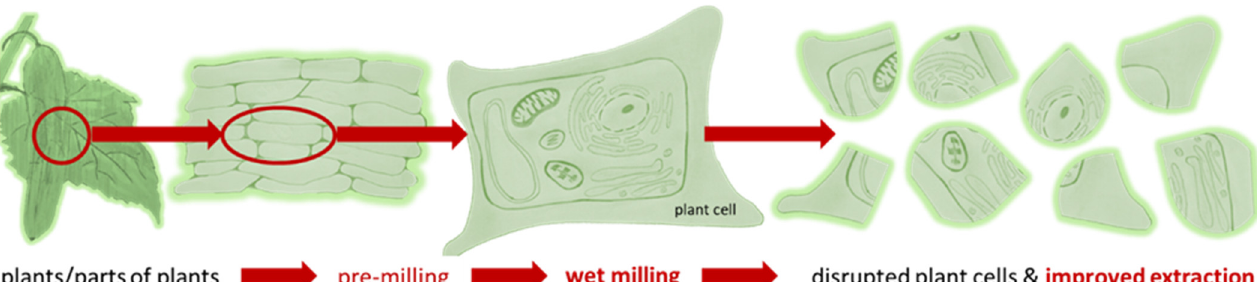
Figure 1. Scheme of PlantCrystal-technology. Plants or parts of plants are subjected to wet milling (bead milling or high-pressure homogenization) to destroy the plant cells exhaustively. This allows for an improved and solvent-free extraction of plant constituents when compared to classical extraction methods.